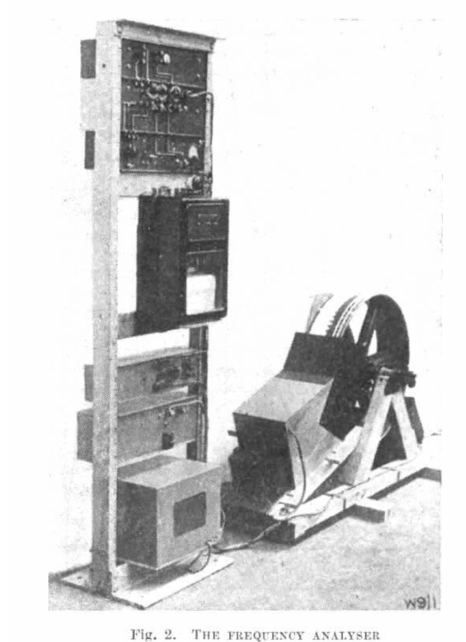
Figure 6: Figure 2 from N. F. Barber, F. Ursell, J. Darbyshire, and M. J. Tucker. 1946. “A Frequency Analyser Used in the Study of Ocean Waves.” Nature 158: 329–32.